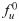
A: Amplitudes of the pattern δu (left) and δv (right) in the parameter space a-Dv obtained by our approach (continuous surfaces) and in numerical simulations (circles) for the activator, u (green in all panels), inhibitor, v, (red in all panels) system described in the main text (Eq 15). The black dashed line indicates the patterning separatrix, Eq (14), and the black circle indicates the parameter values used to obtain the pattern shown in Fig 2A. The central inset shows, graphically, the regulatory interactions between the species u and v as defined by the sign of the linear components, fu0, fv0, gu0, and gv0. B: Trajectories to sample the theoretical solutions. The symbols indicate simulations results and the lines the approximated solutions for fixed values of Dv = 9, 20 (solid and dashed lines respectively) and increasing a, and for fixed values of a = 0.4, 0.9 (solid and dashed lines respectively) and increasing values of Dv.